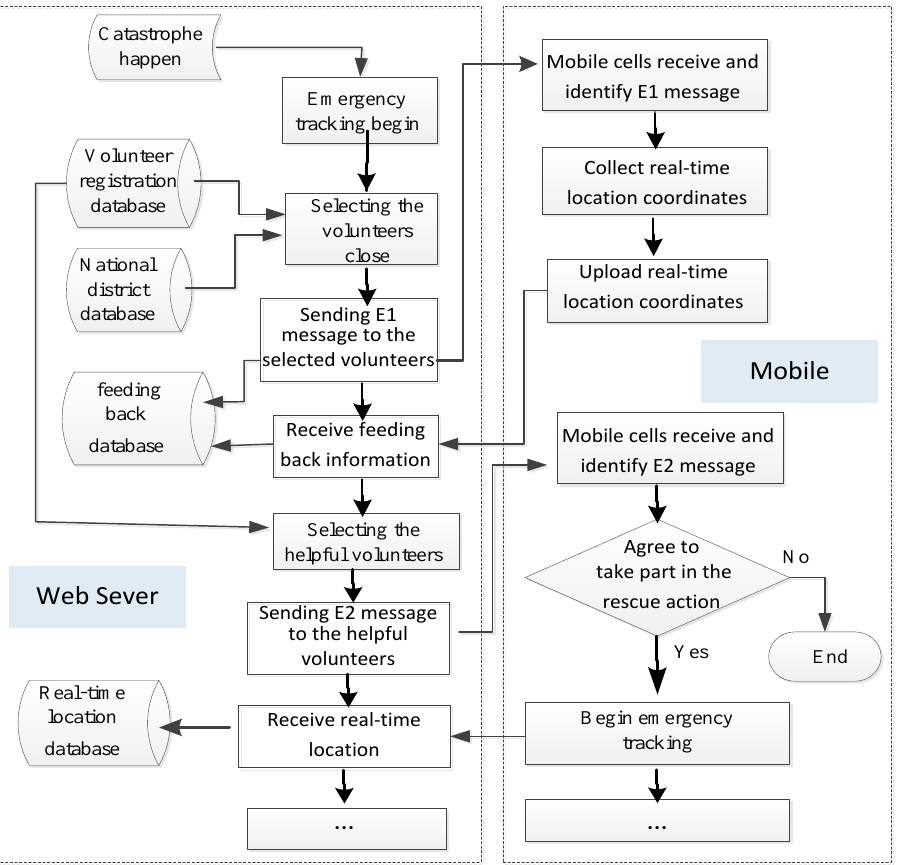
Figure 2 the procedure for e mergency tracking